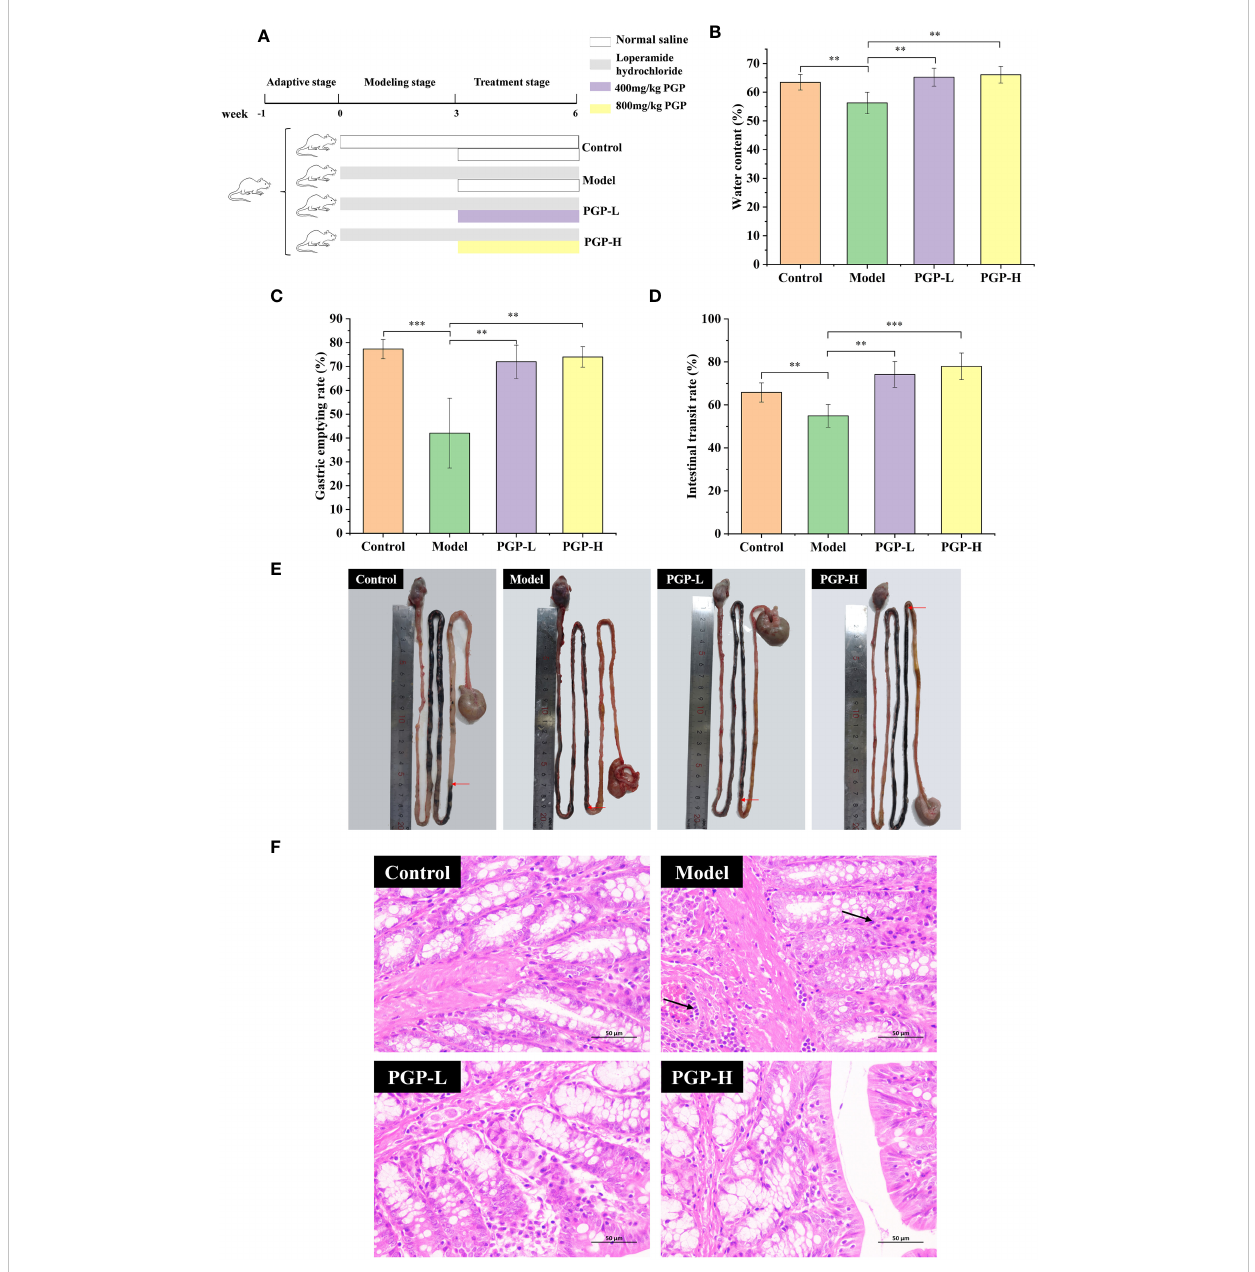
FIGURE 1 Effect of PGP on excretion parameters and pathological detection of colon in rats. (A) Animal experiment fl ow chart. Effect of PGP on gastrointestinal motility, based on (B) fecal water content, (C) gastric emptying rate, and (D) intestinal transit rate. (E) Visual observation was performed to assess intestinal transit. (F) The hematoxylin and eosin staining method was used to analyze the colon sections of rats under light microscope. Red arrows mean the location of the charcoal propulsion in small intestinal, and black arrows mean in fl ammatory cell in fi ltration. ** p < 0.01, *** p <